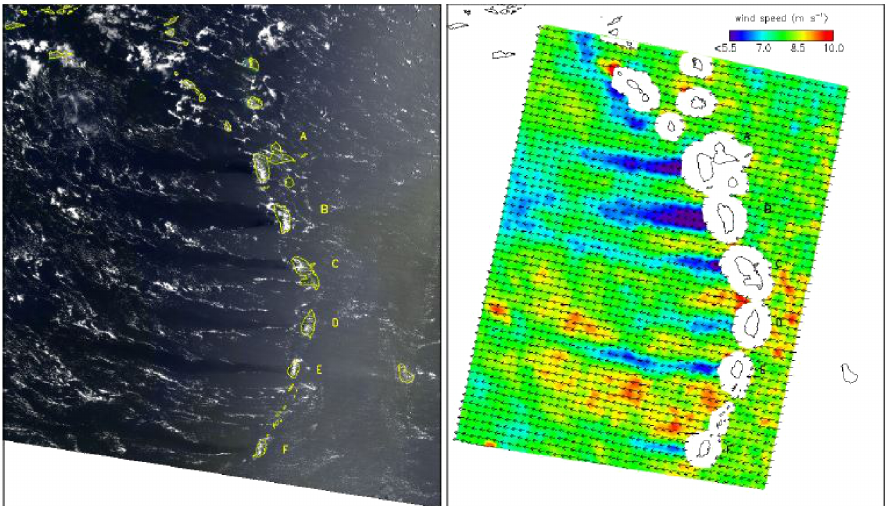
Figure 2. MODIS-TERRA true color image of the Lesser Antilles at 14:40UTC on 1 August 2013 (left panel). Note the dark island wakes embedded in sunglint in the eastern part of the image. Corresponding ASCAT-B 6.25km resolution near-surface winds at 13:26UTC (right panel). For clarity, only every fourth wind vector is plotted.